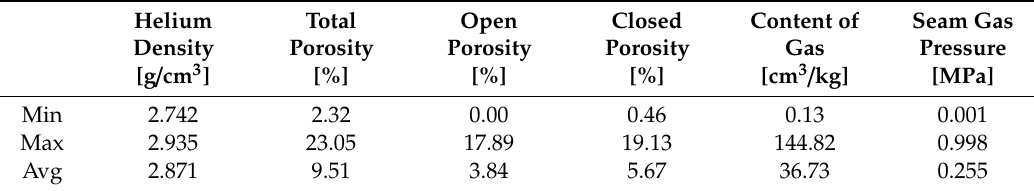
Table 1. Results of analysis of gas-bearing properties of dolomite